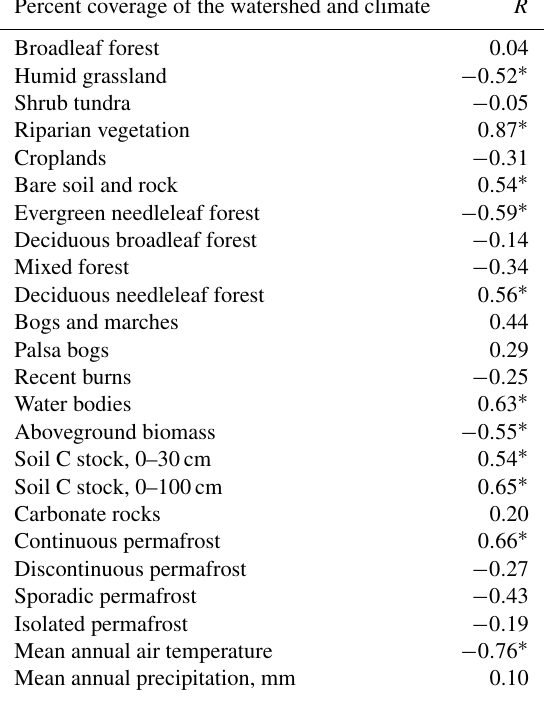
Table 3. Pearson correlation coefficients ( R ) between p CO 2 and landscape parameters of the Lena tributaries. Significant correla- tions ( p < 0 . 05) are marked by an asterisk. Methane concentration did not exhibit any significant correlation with all tested